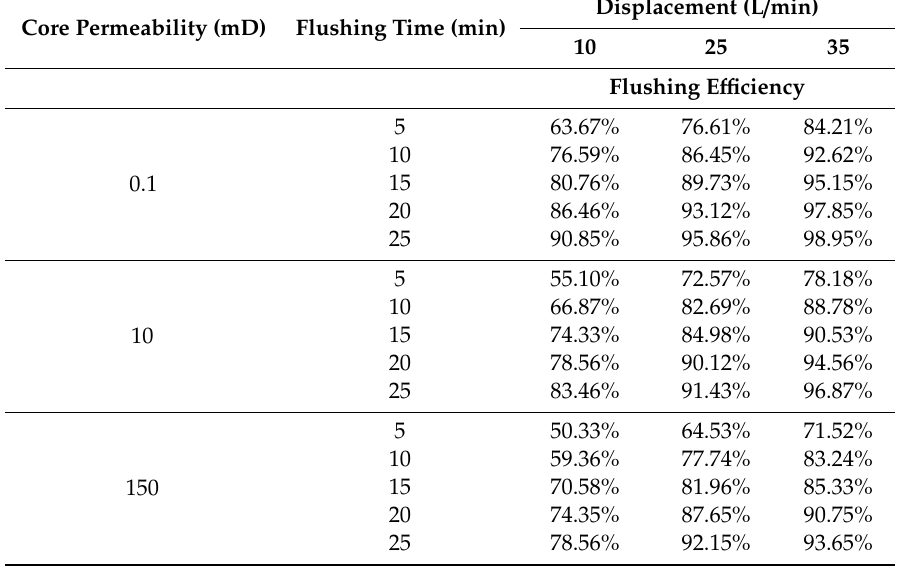
Table 4. Results of flushing e ffi ciency under di ff erent flushing displacement and time.